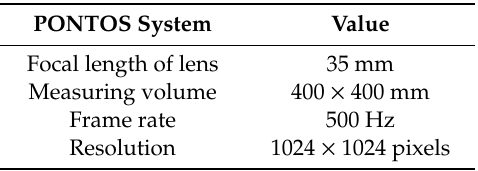
Table 2. Parameter settings in the PONTOS